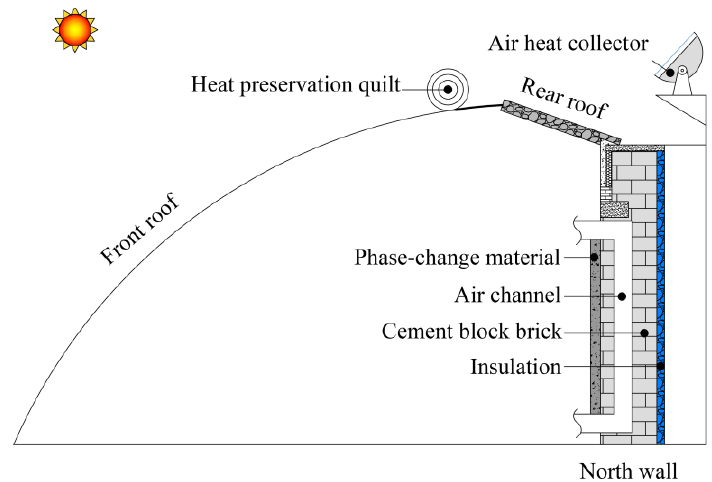
Figure 1. Structure of the solar active-passive “ three-layer ” composite phase change heat storage